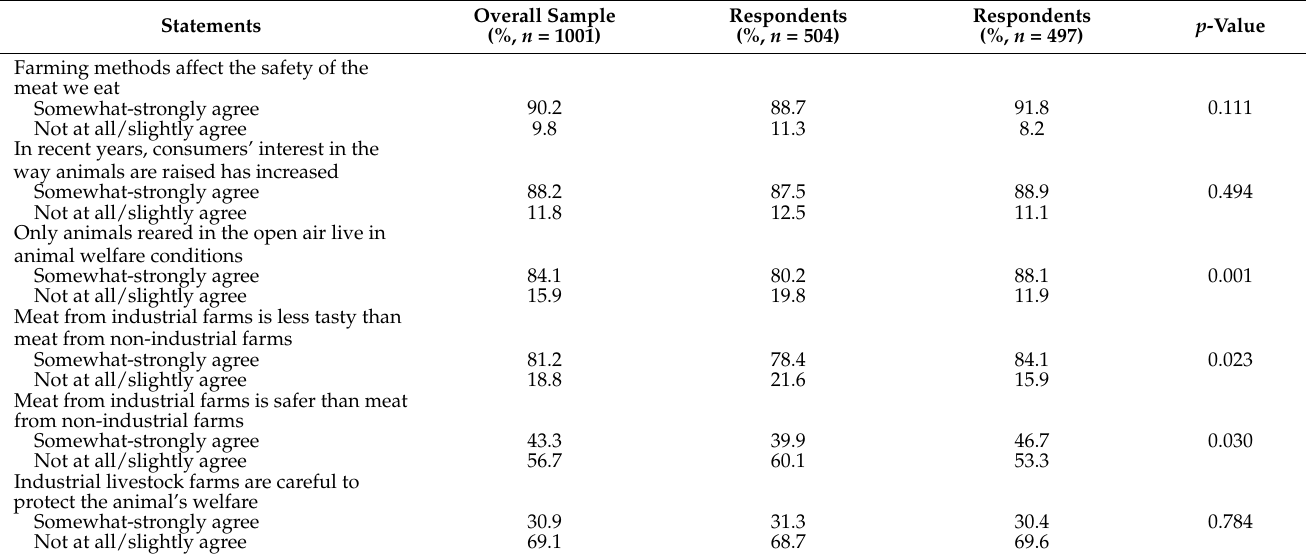
Table 6. Considering animal breeding, how much do you agree with the statements below? Results of the Fisher’s exact